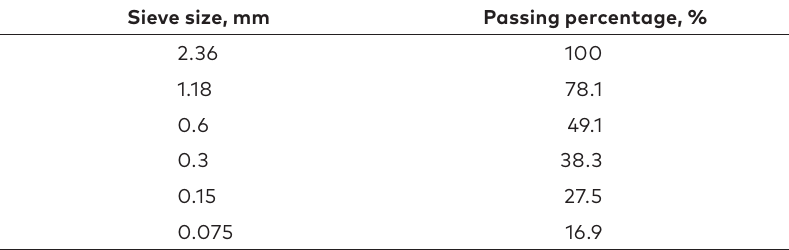
Table 1. Continuous aggregate